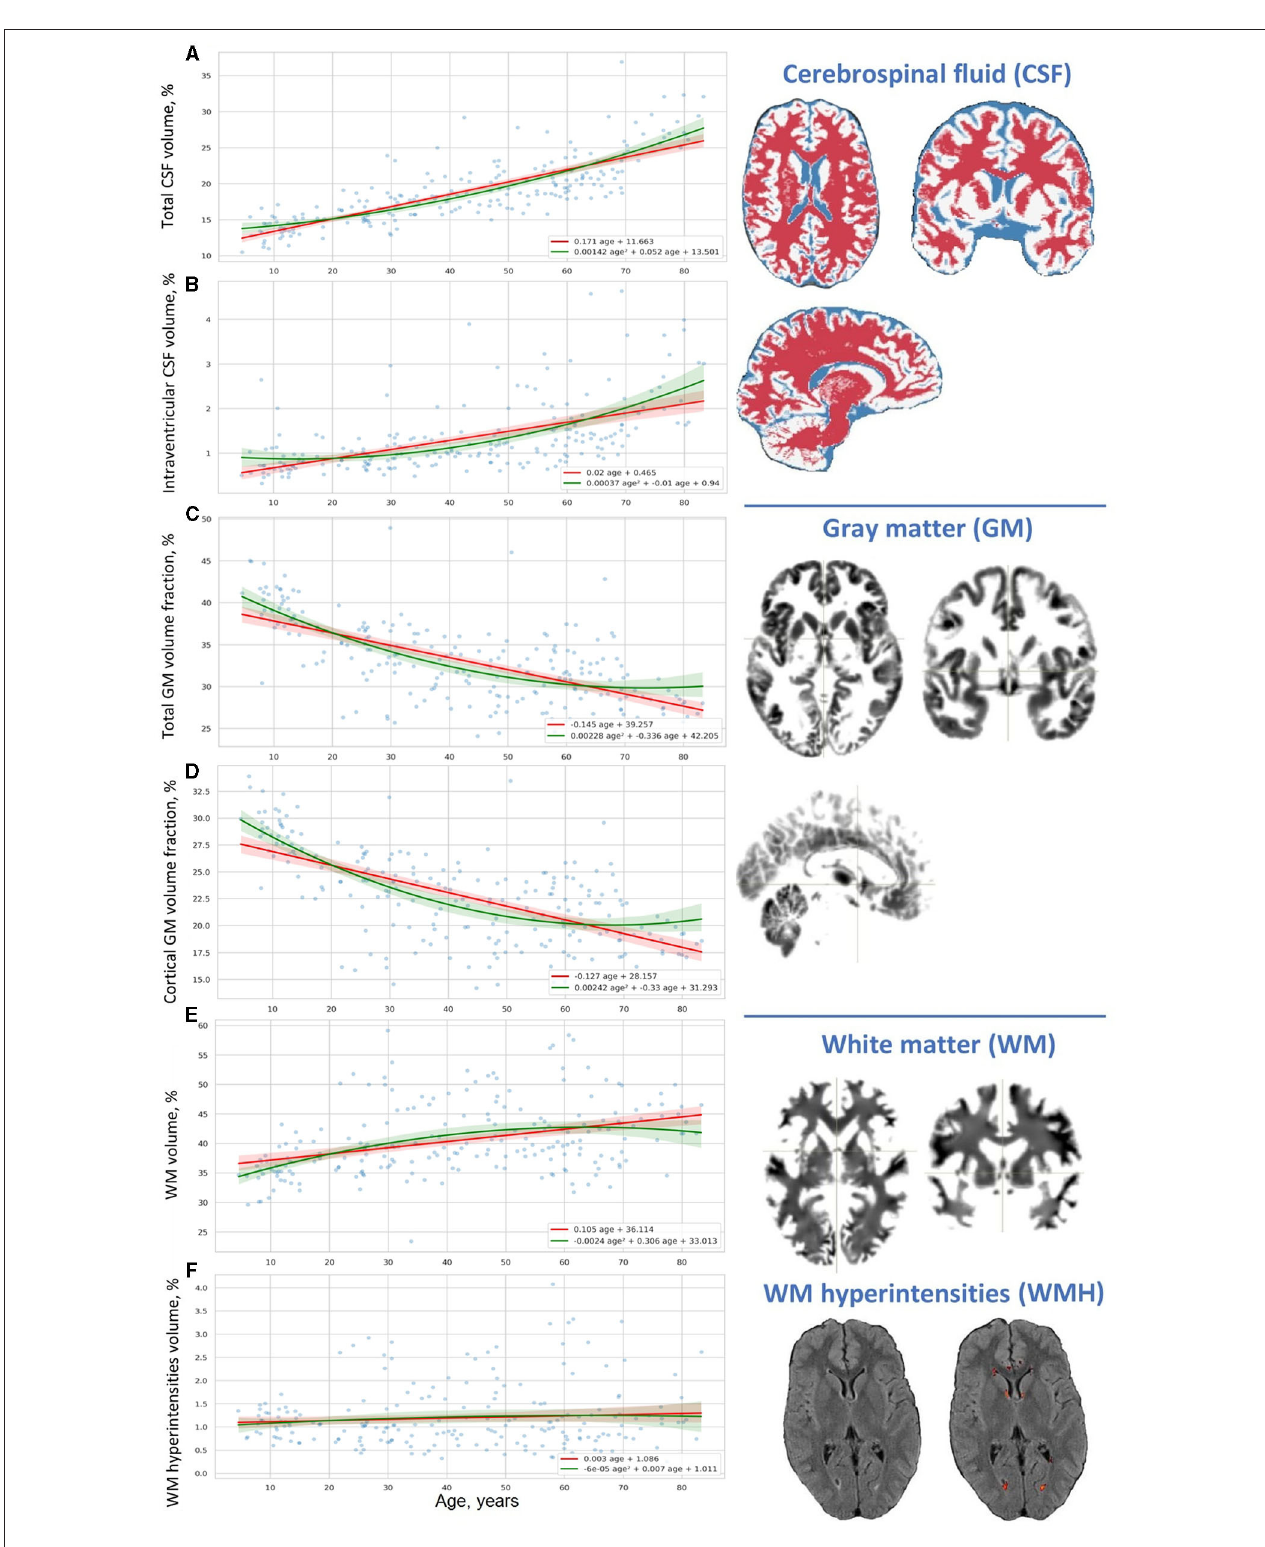
FIGURE 2 | Distribution of results of voxel-based brain morphometry (VBM) over age. (A) Total CSF volume, (B) intraventricular CSF volume, (C) total GM volume fraction, (D) cortical GM volume fraction, (E) WM volume, and (F) WM hyperintensities volume.